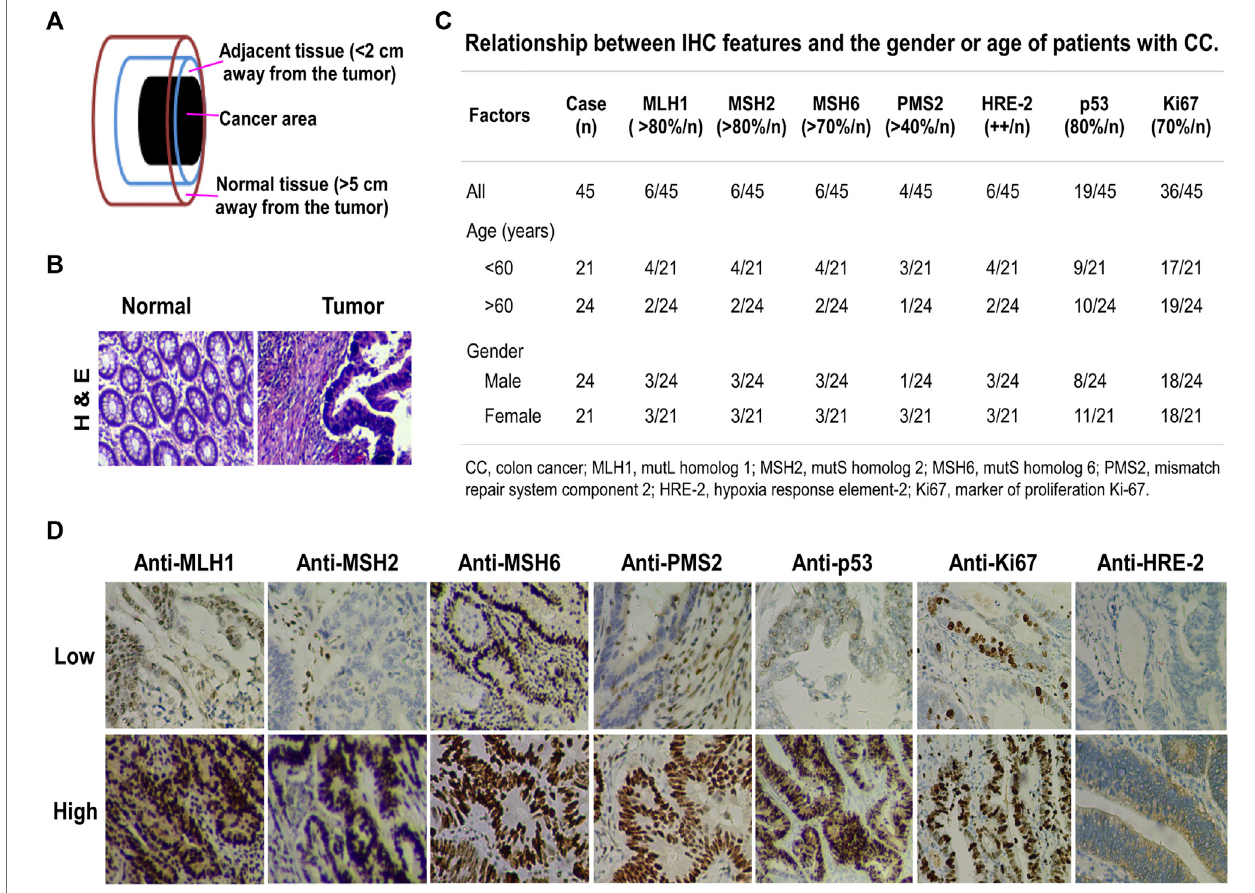
FIGURE 1 | Clinicopathological characteristics of primary diagnosed colon cancer. (A) Tissue samples. Cancer area, the site of pathologically diagnosed colon cancer; adjacent tissue, < 2 cm away from the tumor in which the cells were pathologically normal; normal tissue, > 5 cm away from the cancer. (B) H&E staining, magni fi cation ×200. Left, normal tissue; right, colon cancer tissue. (C) Relationship between IHC features and the gender or age of colon cancer patients. The percentage indicates the amount of positive IHC staining. The number before the slash in the table represents the number of cases in line with the corresponding positive percentage. (D) IHC staining for MLH1, MSH2, MSH6, PMS2, p53, Ki67, and HRE-2 in colon cancer tissues. Upper, IHC low expression; lower, IHC high